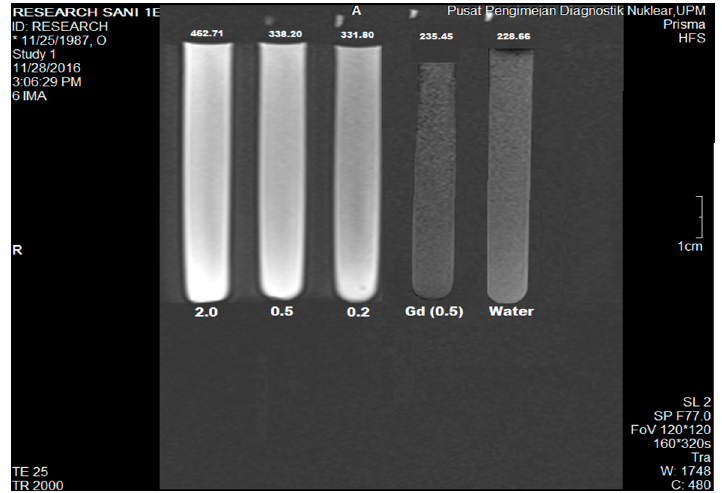
Figure 7. T1 − weighted image of protocatechuic acid loaded on GO/Gd nanocarrier after surface coating with gold nanoparticles (GAGPAu) acquired using Prisma 3 − Tesla MRI at 2.0, 0.5 and 0.2 w / v concentrations of Gd 3+ , 0.5 (Gd w / v ) and water reference.